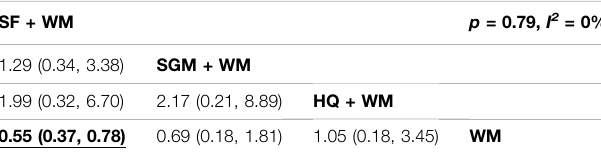
TABLE3| ORswith95%CIsof28-daysmortality.Signi fi canteffectsareprintedin